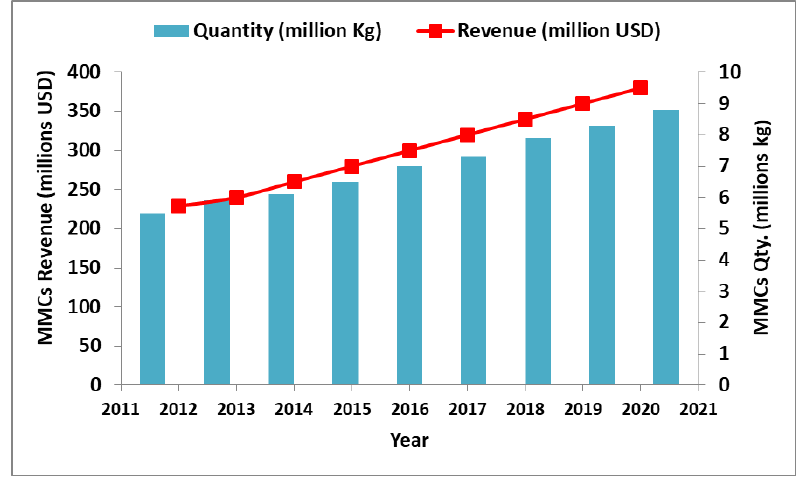
Figure 1. MMCs demand and revenue generated worldwide